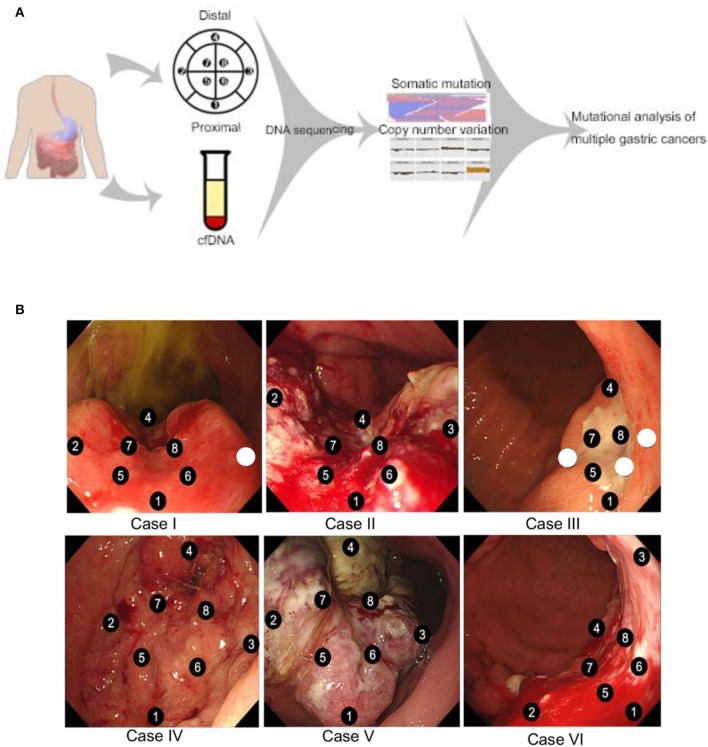
(A) Schematic overview of the study design. Endoscopic mapping was preplanned for eight sectors of the primary tumor with proximal and distal orientation. Tumor tissue somatic mutations and copy number variants were determined by targeted next generation sequencing along with cell free DNA analysis. (B) Endoscopic mapping for multiple biopsy. Eight specimens were obtained from each patient case. Sectors with insufficient purity of tumor DNA for next generation sequencing are represented by unnumbered circles.